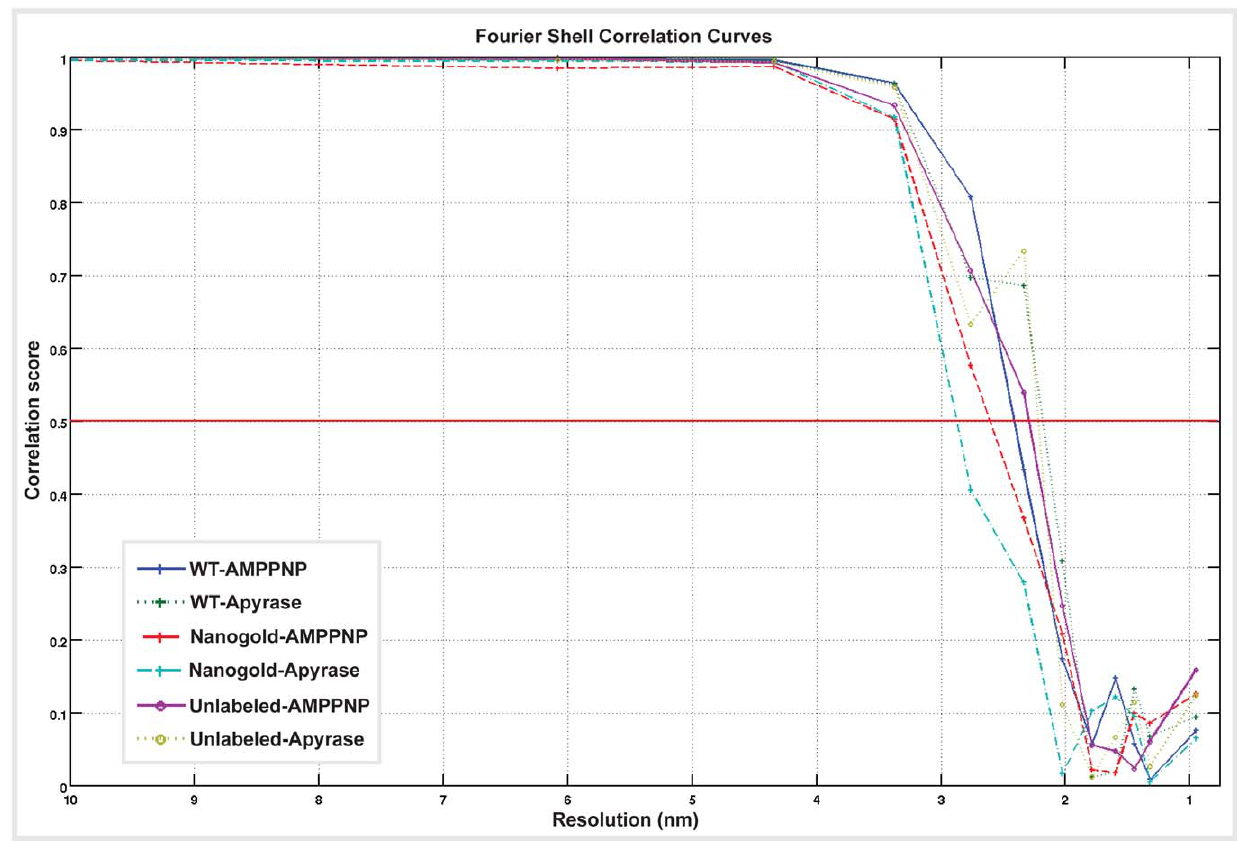
Figure 4. Cryo-EM helical reconstruction and comparison of unlabeled and Nanogold H -labeled Kar3CFVik1C536C-MT complexes. ( A & B ) 0.38 nm cross-sections through helical averages of MTs decorated with GCN4-Kar3CFVik1C536C that has not been labeled with Nanogold H , in the nucleotide-free (A) and AMPPNP ( B ) states. These maps appear indistinguishable from those of wild-type GCN4-Kar3Vik1 (Fig. 3). ( C & D ) 0.38 nm cross-sections through helical averages of MTs decorated with Nanogold H -labeled GCN4-Kar3CFVik1C536C. An additional density (orange circle) corresponding to the Nanogold H is clearly seen protruding from the outer domain in both the nucleotide-free ( C ) and AMPPNP states ( D ). ( E ) Difference map calculated by subtracting the unlabeled map in A from the Nanogold H -labeled map in C . Differences that are statistically significant for P , 0.001 are shown in color. The difference map is overlaid on the helical average from A to show that the significant differences correspond to the position of the Nanogold H providing evidence that Vik1 is the outer domain and Kar3 is in contact with the MT. ( F ) Difference map obtained by subtracting the average in B from the average in D , overlaid on the average from B , shows similar results for the AMPPNP state.